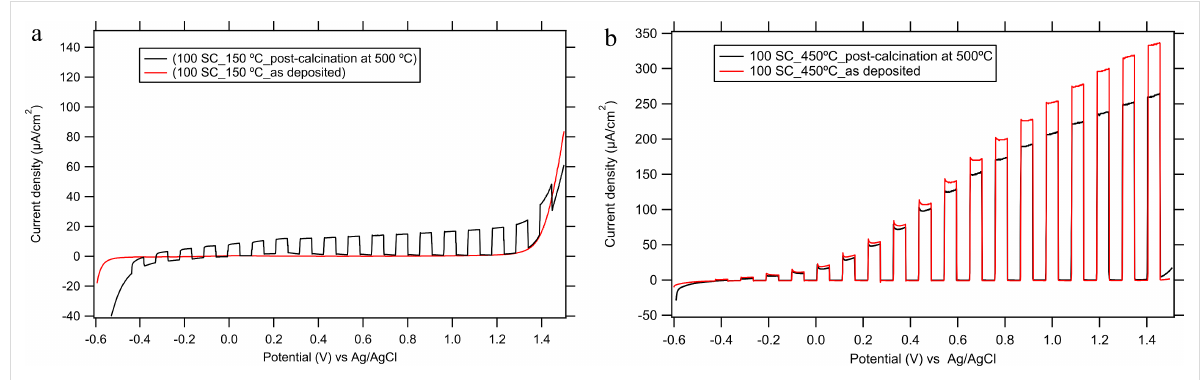
Figure 1: Linear sweep voltammetry under intermittent UV light excitation (Hg lamp 320–380 nm) of intensity 7.5 mW/cm 2 . Comparison of TiO 2 films (100 SCs) deposited on FTO (A) at 150 °C (a) and 450 °C (b) with and without subsequent calcination. The electrolyte solution was 0.1 M Na 2 SO 4 (pH 10), dark/light intervals of 10 s were applied.